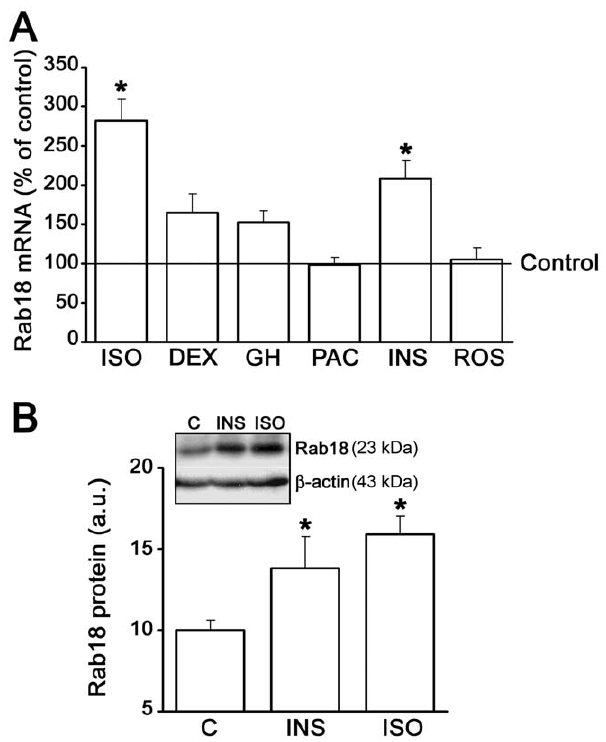
Figure 2. Regulation of Rab18 gene expression and protein content in 3T3-L1 adipocytes. (A) 3T3-L1 adipocytes were treated with 10 m M isoproterenol (ISO), 100 nM dexamethasone (DEX), 10 nM GH, 4.8 nM PACAP (PAC), 100 nM insulin (INS), or 10 m M rosiglitazone (ROS) for 24 h, and Rab18 mRNA levels were evaluated by quantitative RT-PCR. 18S rRNA expression was used as internal control (1.7 6 10 9 6 9.2 6 10 8 and 1.1 6 10 12 6 1.5 6 10 11 Rab18 and 18S cDNA copies, respectively, per 0.1 m g total RNA in untreated cells). Data represent the average 6 SEM of 3 independent experiments. *, P , 0.05 vs. untreated cells. . (B) Quantification of Rab18 band intensity in extracts from 3T3-L1 adipocytes cultured in the presence or absence of 100 nM insulin (INS) or 10 m M isoproterenol (ISO) for 24 h s. b -actin immunostaining was used as loading control. Data are expressed as the mean 6 SEM of 3 independent experiments. *, P , 0.05 vs. untreated cells. A representative immunoblot of Rab18 and b -actin is shown.